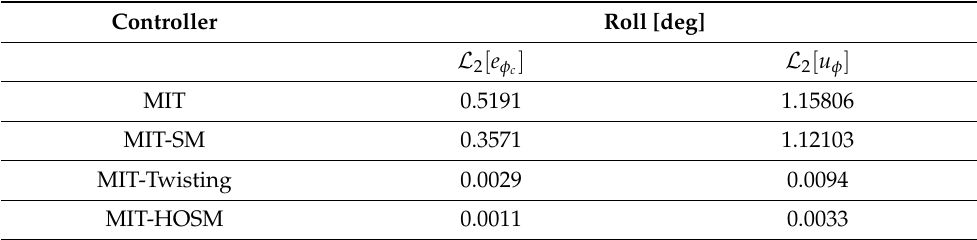
Table 2. Numerical results with L 2 of the adaptive robust controllers in roll